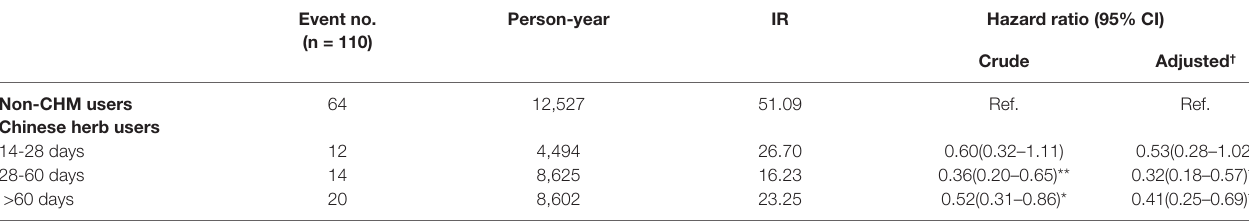
TABLE 5 | Hazard Ratios and 95% confidence intervals of lung cancer risk associated with cumulative use day of CHM among COPD patients.